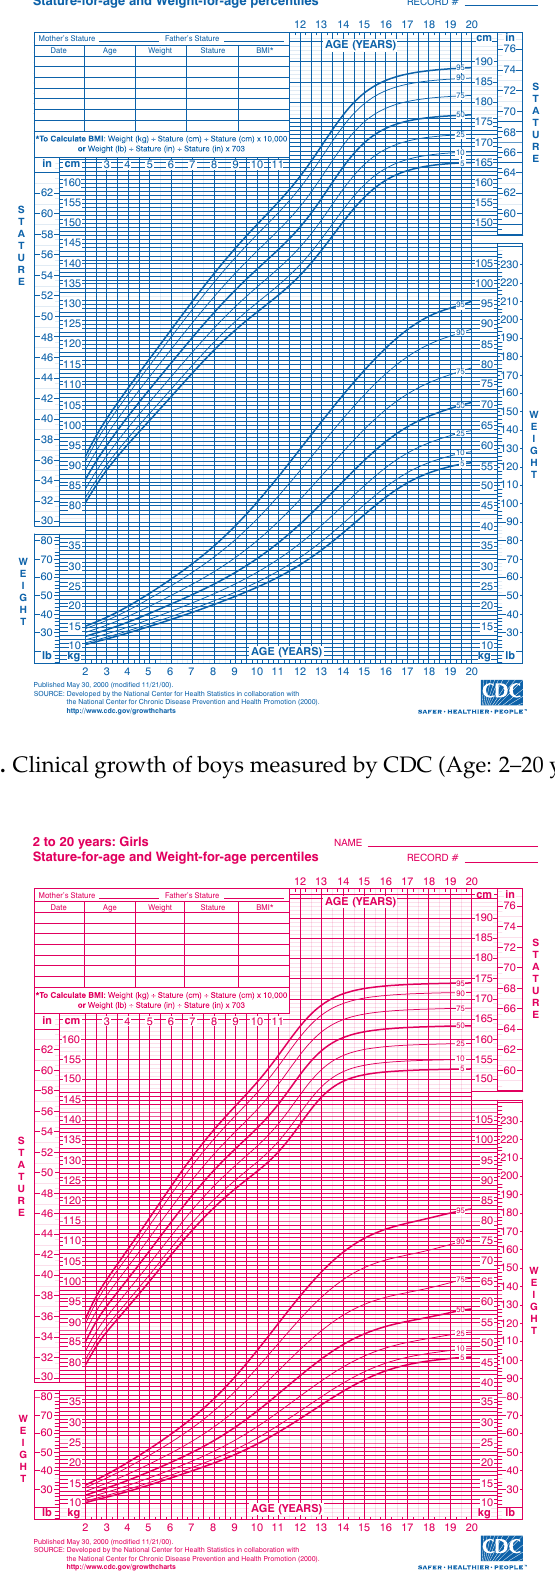
Figure 3. Clinical growth of girls measured by CDC (Age: 2–20 years)